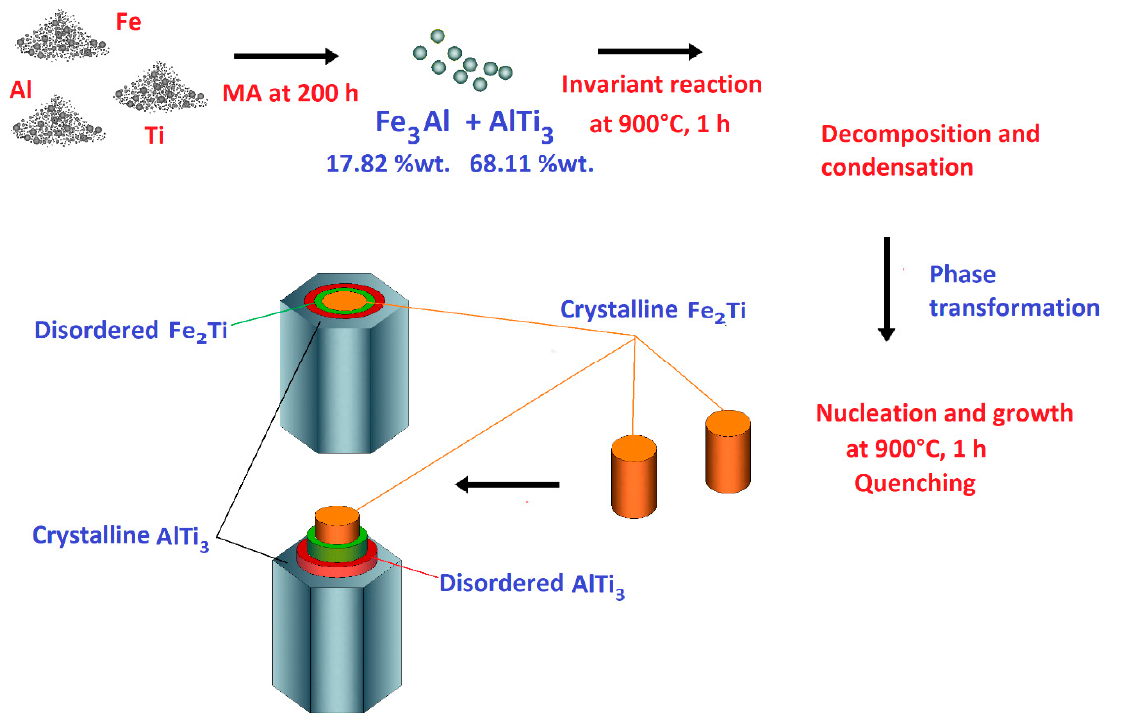
Figure 9. Schematic illustration of the evolutions of phase and rod formation during mechanical alloying and sintering at 900 °C.